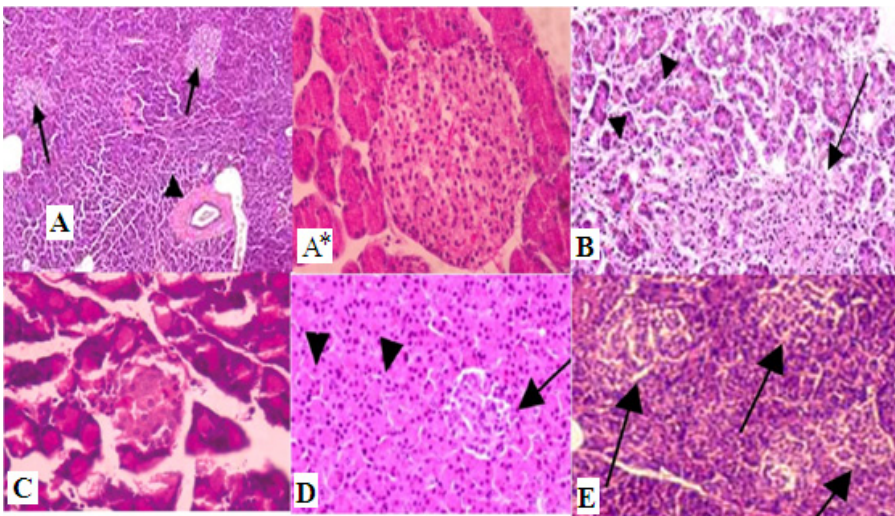
Figure 3. Histopathology graphs shows ( A ) Control, normal pancreas showing normal islets of Langerhans in between normal pancreatic acini (arrow) and normal pancreatic duct (arrow head); ( A *) normal pancreatic acini (×100); ( B ) Diabetic pancreas showing ruptured and destructed islets of Langerhans with damage in B-cells; ( C ) Diabetic and ZnONP group, pancreas showing some normal islets of Langerhans with some destructed one in between normal pancreatic acini and normal pancreatic duct; ( D ) Diabetic and SNP rats pancreas showing ruptured and destructed islets of Langerhans with damage in B-cells (arrow); and ( E ) Diabetic insulin rats pancreas showing ruptured and destructed islets of Langerhans with damage in B-cells. Hematoxylin and Eosin (H&E)